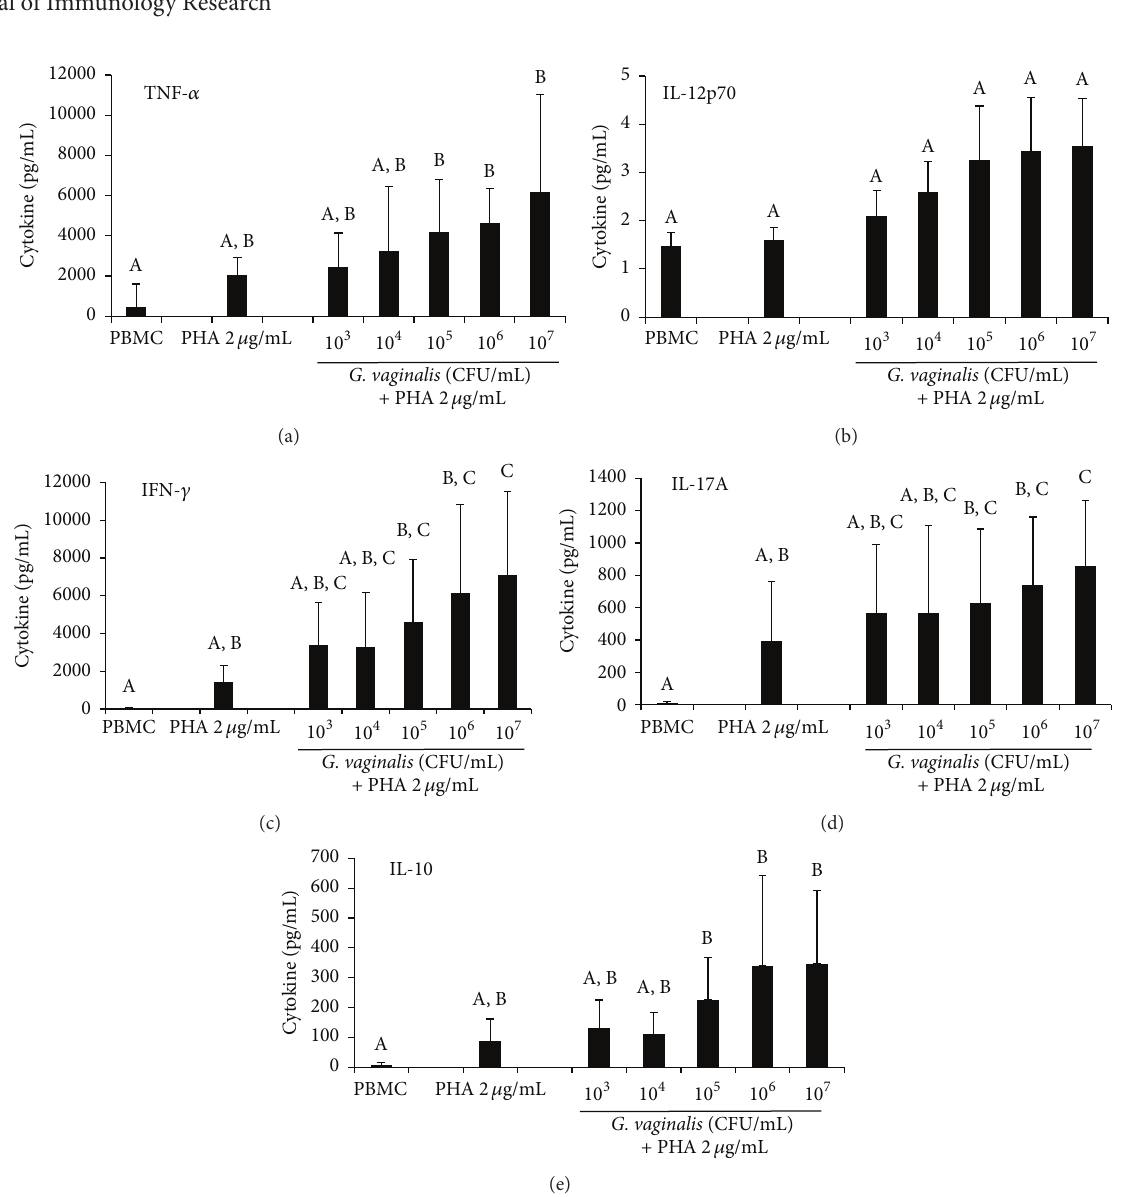
Figure 7: Modulation of PHA-induced cytokine secretion after exposure to a range of G. vaginalis concentrations. (a) TNF- 𝛼 secretion ( 𝑛 = 6 ). (b) IL-12p70 secretion ( 𝑛 = 8 ). (c) IFN- 𝛾 secretion ( 𝑛 = 7 ). (d) IL-17a secretion ( 𝑛 = 8 ). (e) IL-10 secretion ( 𝑛 = 8 ). Compared to the PHA-stimulated control cells, a significant and dose-dependent increase in cytokine secretion was observed for IL-17a and IFN- 𝛾 with the G. vaginalis -treated cells. Other cytokines showed no significant increase in secretion. Data are means (+ SD). PBMC: PBMCs cultured for 72 h without any effector; PHA control: PBMCs only exposed to PHA (2 𝜇 g/mL) for 72h; G. vaginalis : PBMCs exposed for 72 h to PHA (2 𝜇 g/mL) in the presence of 10 3 to 10 7 CFU/mL of G. vaginalis . Friedman’s test with Nemenyi’s comparison ( 𝑝 < 0.05 ). A, B, and C: means with different superscript letters are significantly different from each